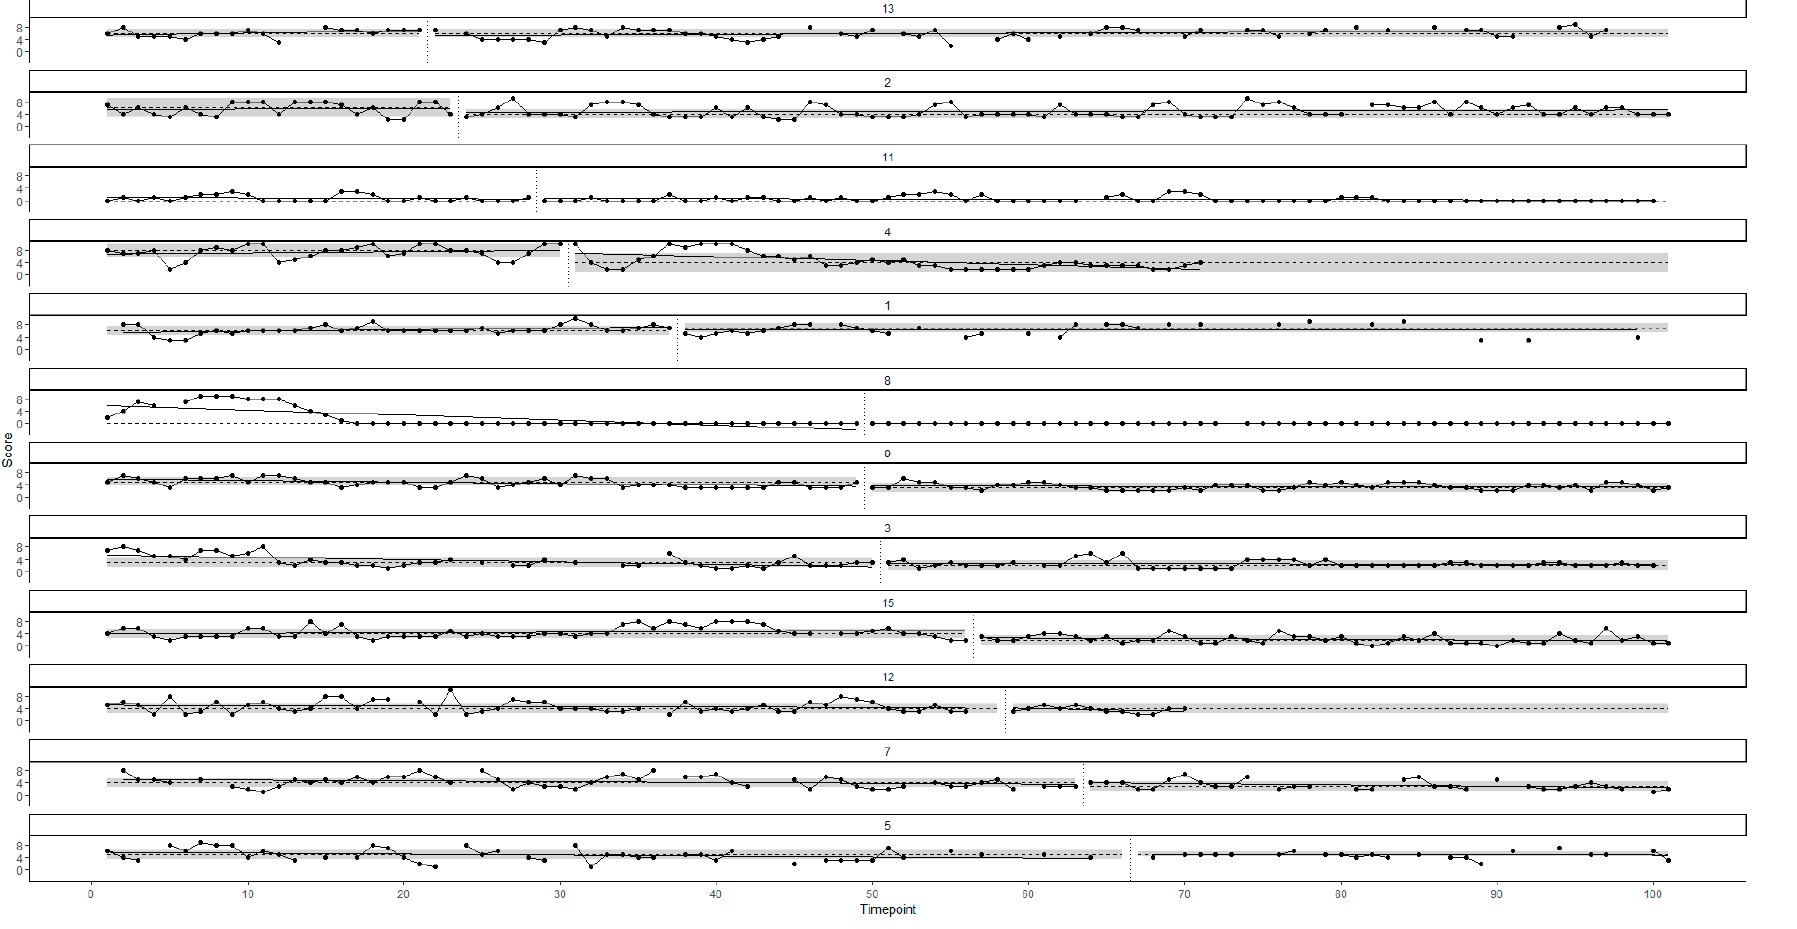
Figure A3. SCED data for all study 2 participants on daily measure of stress. Note: Participant data are ordered via the order in which they received the intervention. Vertical dotted lines denote the data point at which the intervention was delivered. Shading denotes the one median absolute deviation from the median. Dashed horizontal lines denote the median while solid lines denote within-phase OLS regression trend lines.